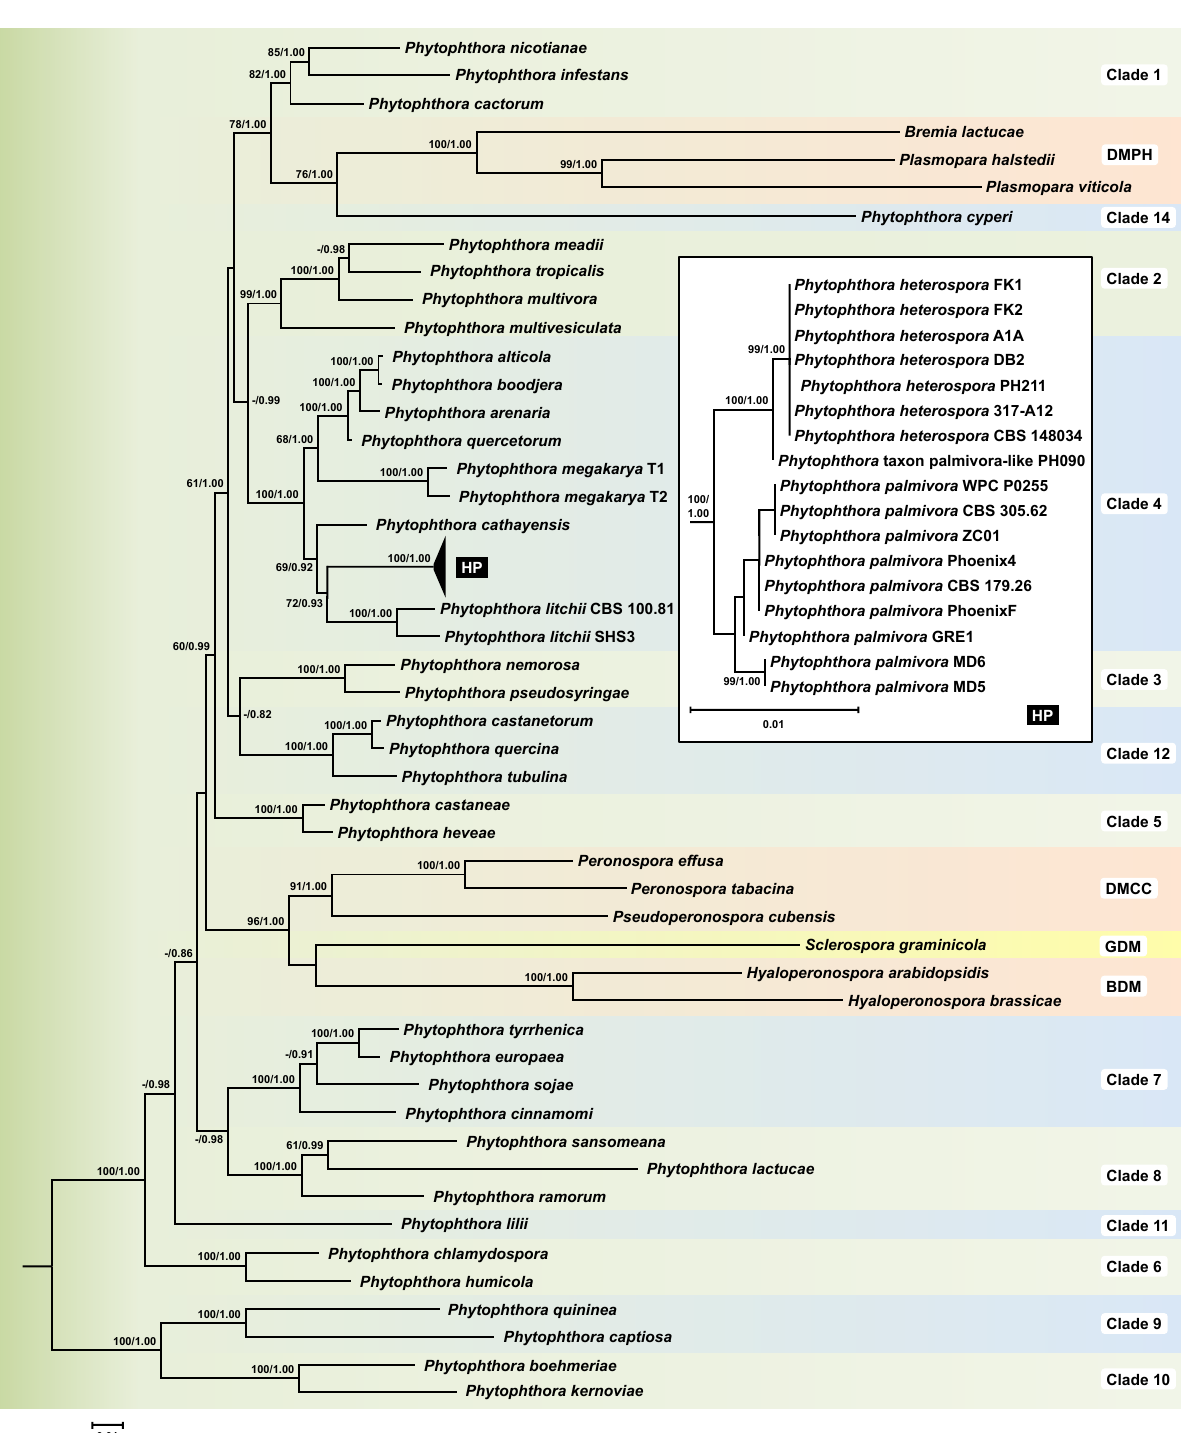
Figure 2. Fifty percent majority rule consensus phylogram derived from maximum likelihood analysis of a concatenated four-locus (ITS, Btub , cox 1, nadh 1) dataset of representative species from phylogenetic clades 1–12 and 14 of Phytophthora and the four downy mildew groups DMPH, DMCC, GDM, and BDM. Maximum likelihood bootstrap values and Bayesian posterior probabilities are indicated but not shown below 60% and 0.80, respectively. Nothophytophthora valdiviana was used as outgroup taxon (not shown). Scale bar = 0.01 expected changes per site per